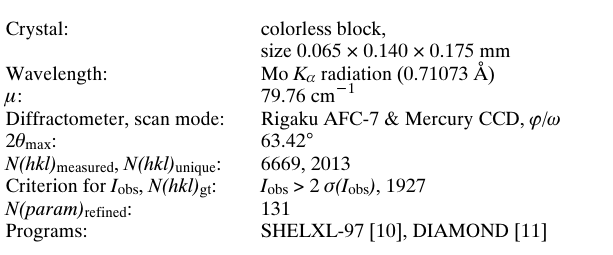
Table 1. Data collection and handling.